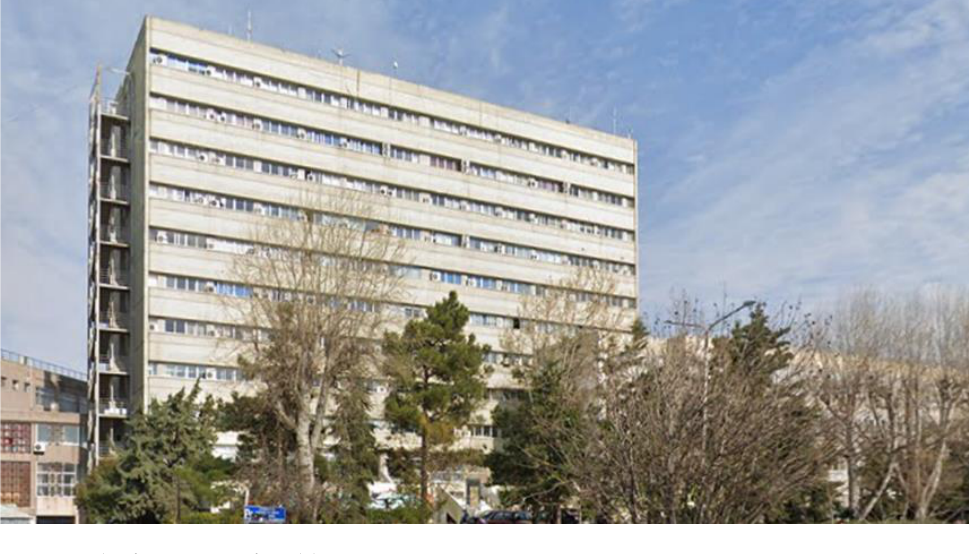
Figure 2. The f ront view of Building D’. Figure 2. The front view of Building D’.